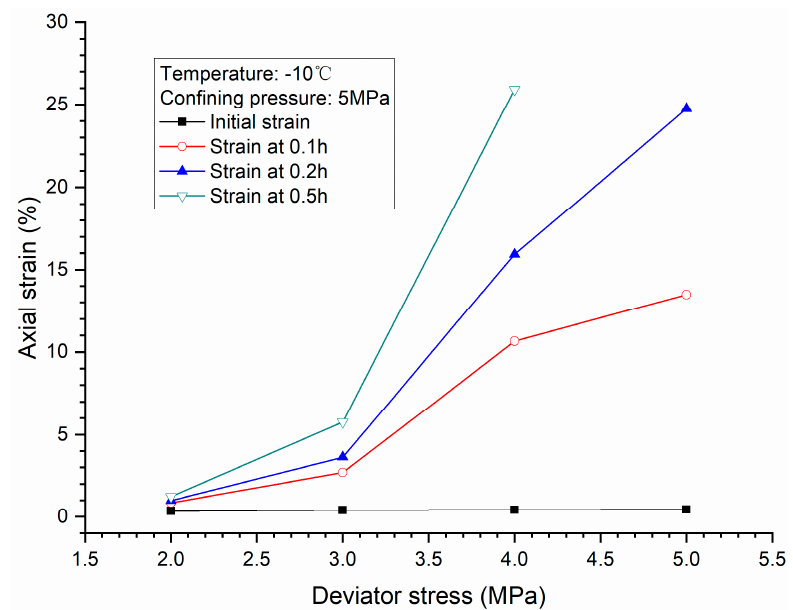
Figure 7. Creep strain rate versus axial strain for methane hydrate-bearing frozen specimens under high deviator stresses.